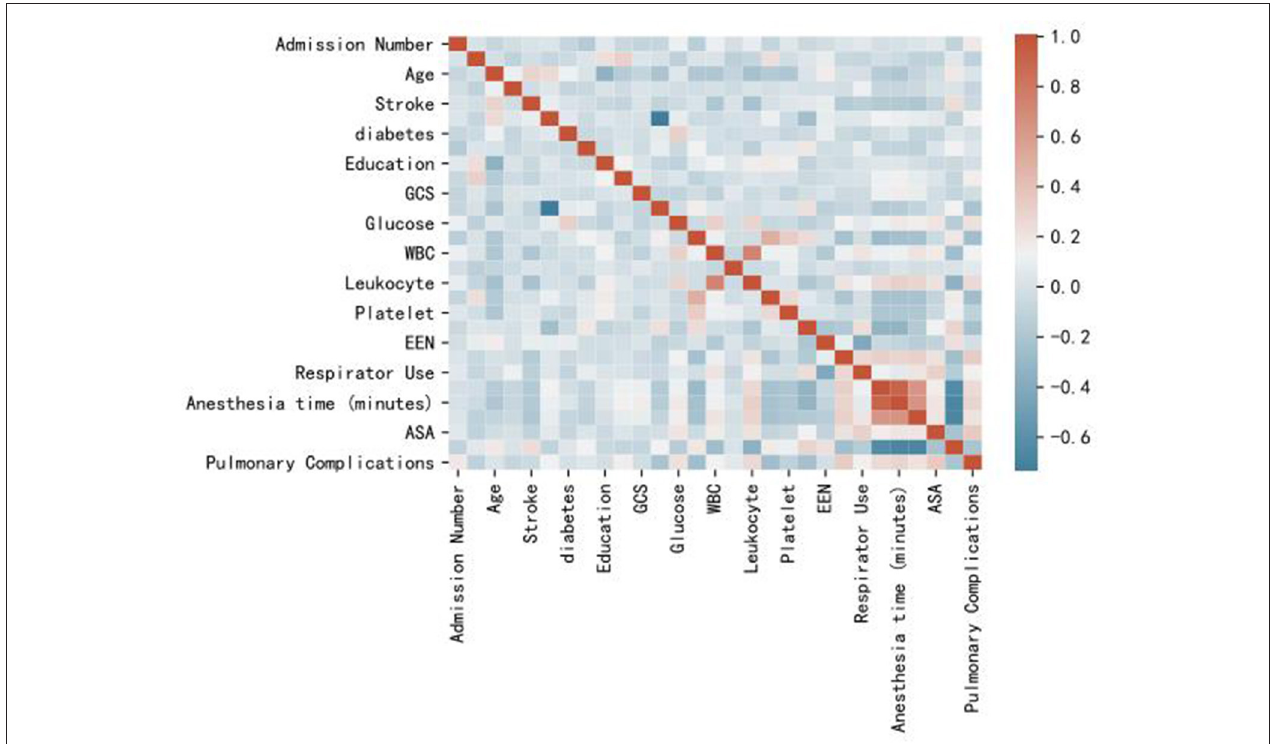
FIGURE 3 | Heat map of correlation analysis results indicates the the risk factors association with